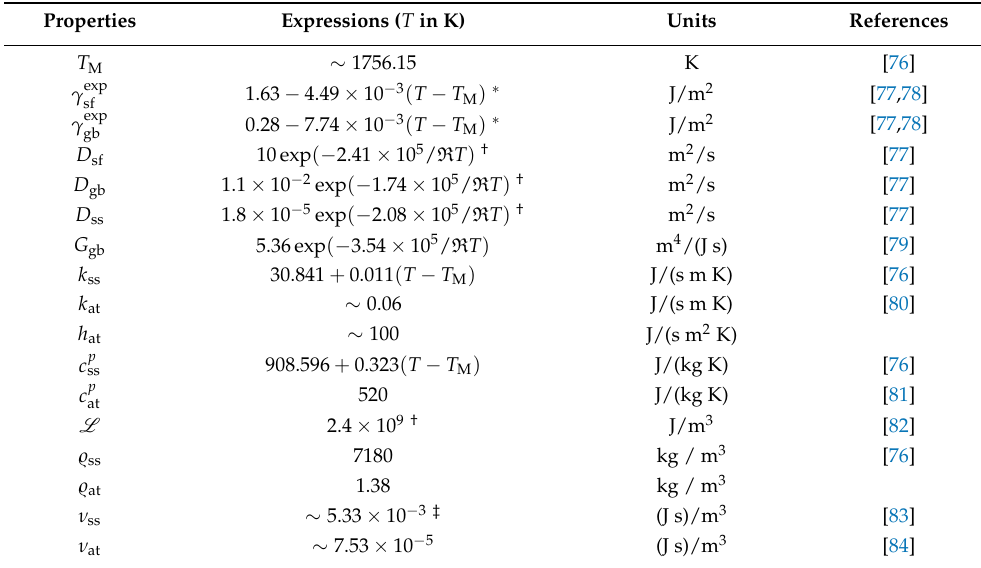
Table 2. Material properties of the ferritic PM2000 alloy and Ar atmosphere, employed in the simula-